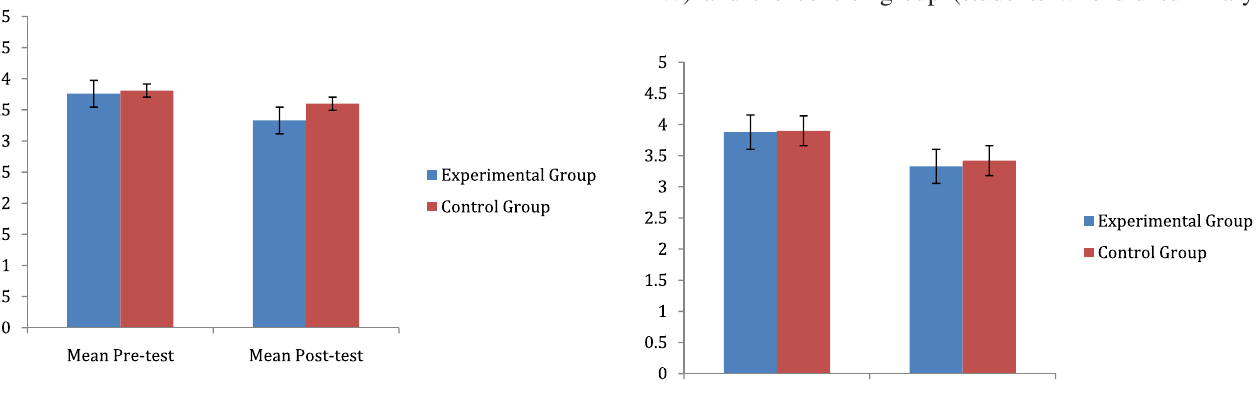
FIG. 1. Calgary study. Mean pre- and post-score of the certainty or simplicity knowledge factor for experimental and control groups with 5% error bars. (Low score is more expertlike reasoning.)